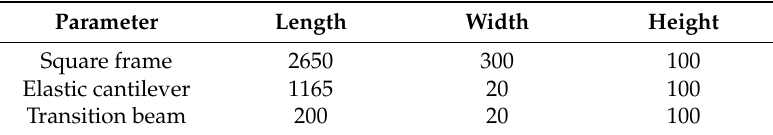
Table 2. Design parameters of the ROTE structure.